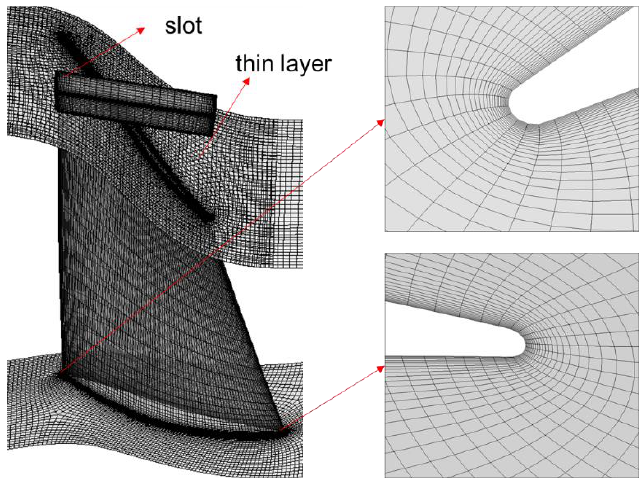
Figure 3. Computational domain mesh.